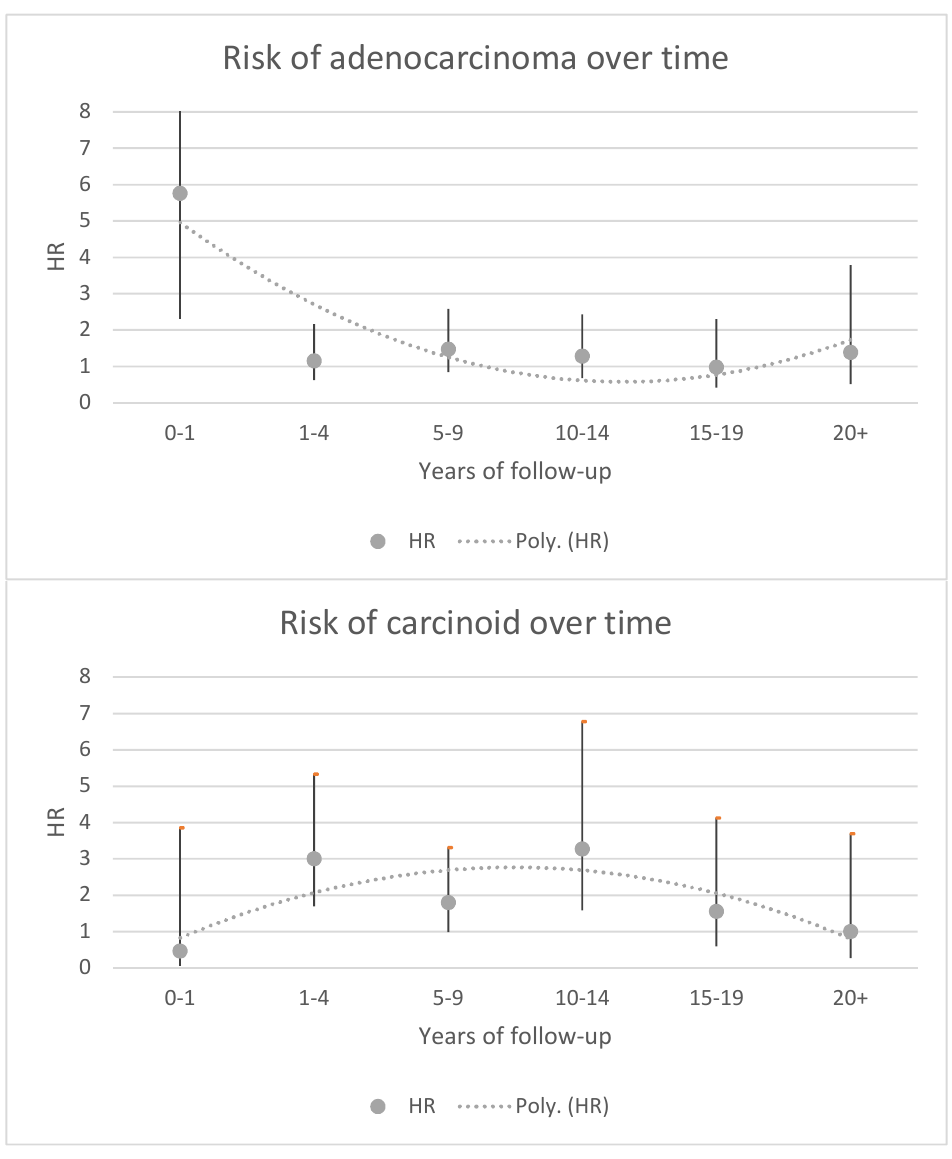
(Table 4). The overall incidence rate was 4.2 in individuals with GBD vs. 1.8 in matched comparators, hence absolute risk difference is 2.4 additional cases per 100,000 PY.